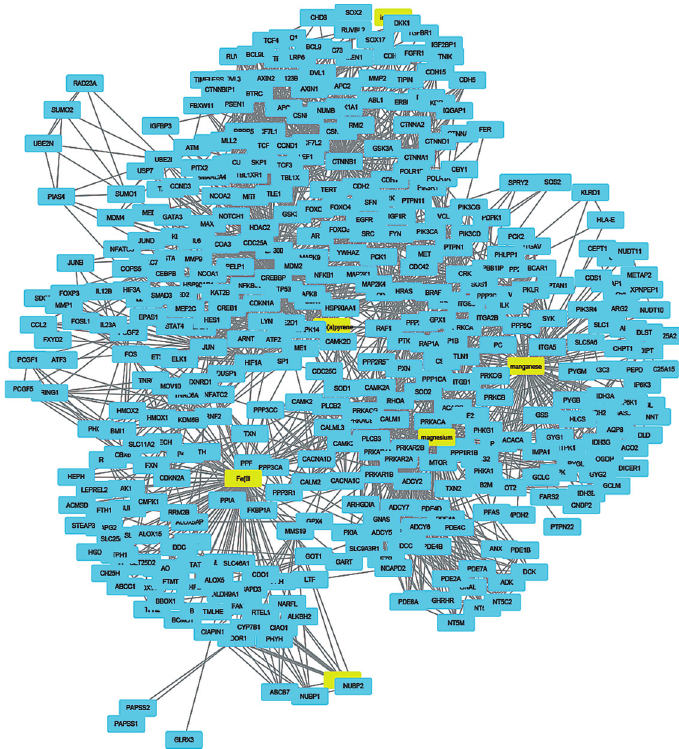
Figure 6 - Cluster analysis of the major CPI-PPI network showing the association of cluster 9 with IEs and PAHs (yellow). It is composed of 249 nodes and 2,180 edges, with Ci = 17,44. The associated compounds are S, Cr, Ti, and benzo[a]pyrene.